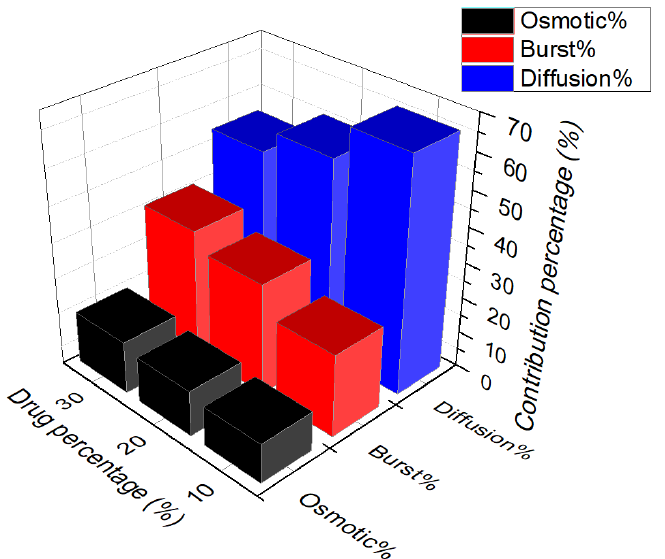
Figure 5. Percentage of the contribution of each mechanism during the drug release from PU films with the three different percentages of the drug at the flow rate of 7.5 mL/s. with the three different percentages of the drug at the flow rate of 7.5